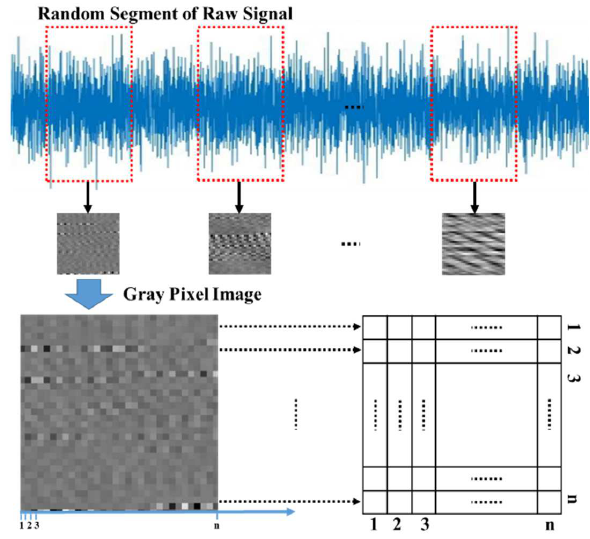
Figure 5. The process of the vibration signal-to-image transformation. ( ) 2 1 2 = ⋯ , , , , L i i n is selected from the continuous raw Firstly, a signal segment data. Then, it is converted into a gray matrix image of dimension · n n size image. ( ) , P i j is the pixel strength of the image, that is calculated by